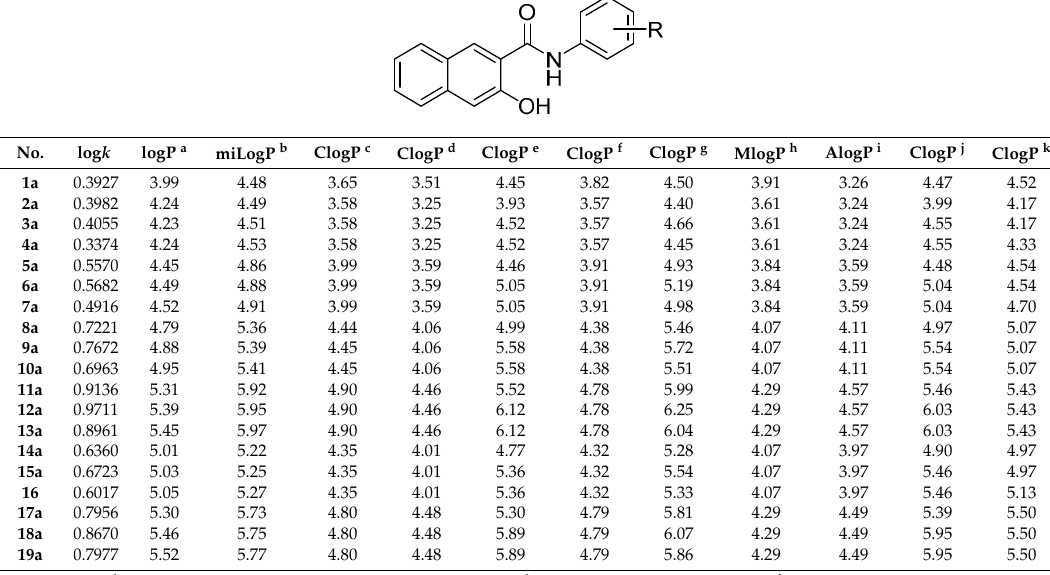
Table 1. N -substituted 3-hydroxynaphthalene-2-carboxanilides 1a – 19a (series A), as well as their determined log k and theoretical partition coefficients calculated by alternative methods.